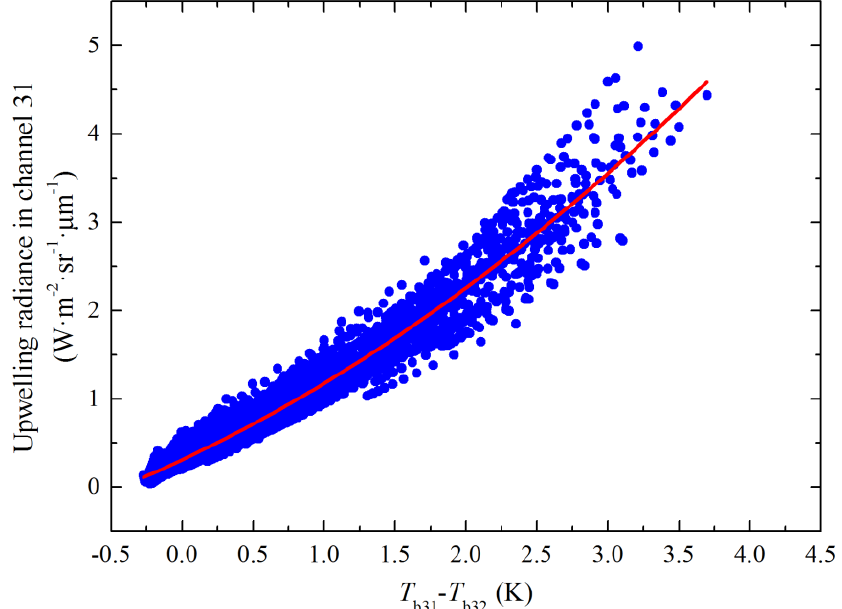
Figure 3. Scatter plot between the simulated atmospheric upwelling radiance in MODIS channel 31 and differences in the at-sensor brightness temperatures of channel 31 and 32 ( T − T ). b31 b32